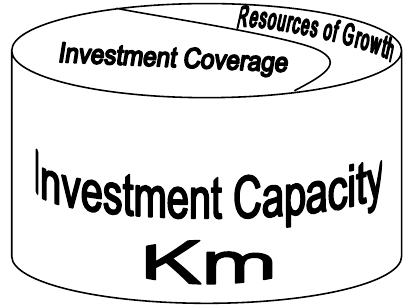
Fig. 1. The relation between variables of logistic